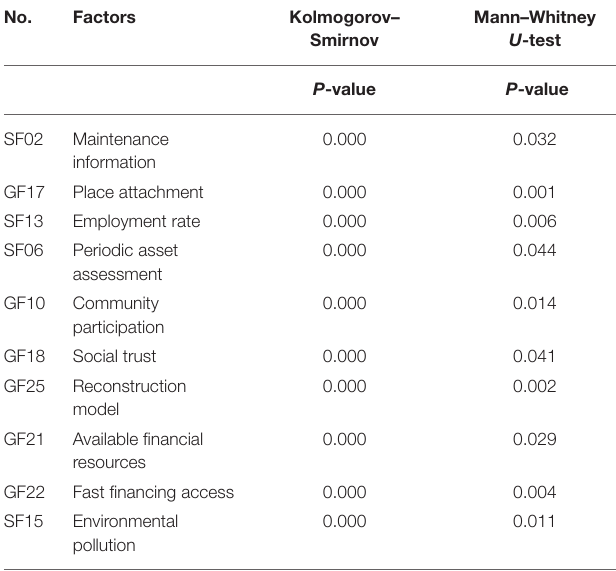
TABLE 5 | Significance test results of Group A and Group